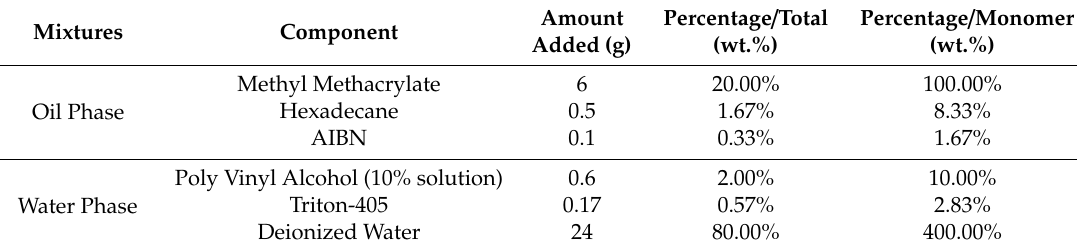
The basic recipe for the synthesis of PMMA / GO nanocomposite latex via miniemulsion